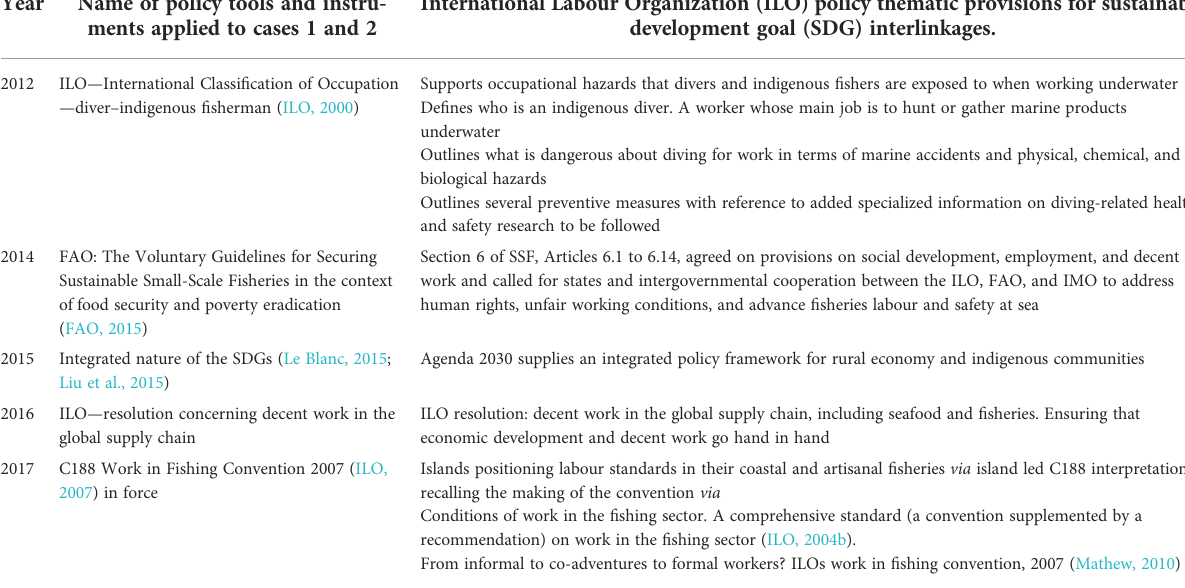
TABLE 1 List of policy-level instruments and thematic data set studied. Year Name of policy tools and instru- ments applied to cases 1 and